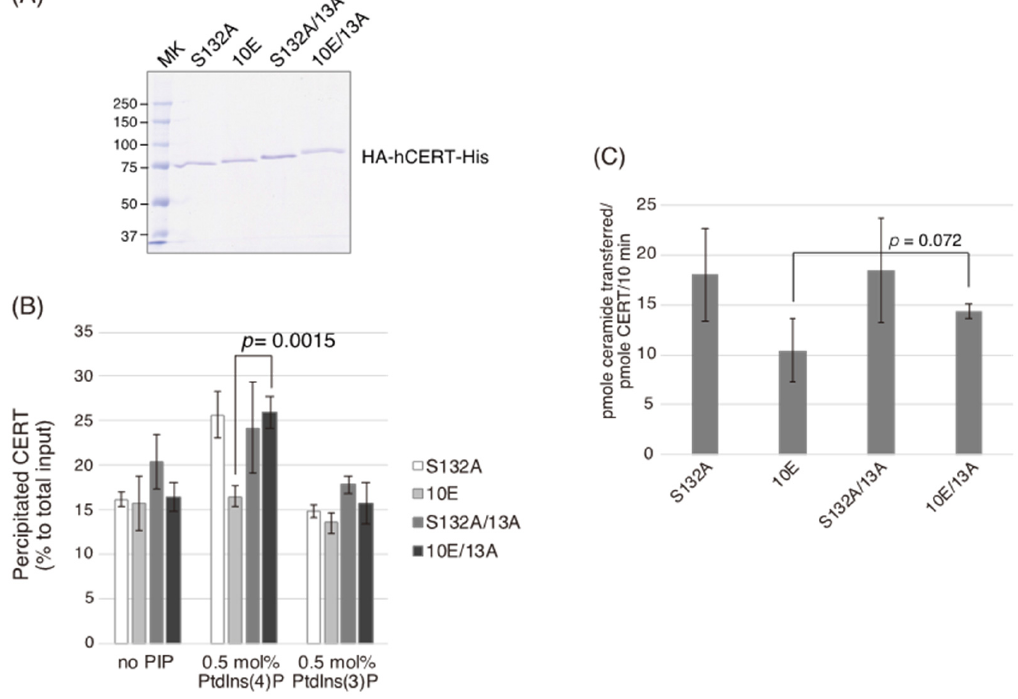
Figure 5. The 13A mutation restores the ceramide-transfer and PtdIns(4)P-binding activities of CERT 10E. ( A ) Quantities (0.5 µ g) of recombinant CERT S132A, 10E, S132A/13A, and 10E/13A proteins purified from Sf21 cells were resolved by SDS-PAGE and stained with Coomassie brilliant blue. ( B ) The binding of purified WT and CERT mutants to liposomes without or with 0.5 mol% PtdIns(3)P or PtdIns(4)P was determined by quantification of their distribution in the supernatant and pellet fractions, respectively. Results shown are the means and SEM of three experiments. Sig- nificance was determined using a two-tailed Student’s t -test; p -values < 0.05 were considered statis- tically significant. ( C ) The transfer of [ 14 C]ceramide from donor to acceptor liposomes by CERT was measured. Results shown are the means and SEM of four experiments. Significance was determined using a two-tailed Student’s t -test; p -values < 0.05 were considered statistically significant. 2.5. The 13A Mutation Partially Destabilizes the Trimeric State of CERT As the CCR is located in the vicinity of a region between amino acids 260 and 264, which was previously reported to be required for CERT trimerization (Figure 1A) [19], we assessed the oligomerization states of the four CERT constructs. To this end, the purified proteins were treated with a non-cleavable chemical cross-linker [ethylene glycol bis (suc- cinimidyl succinate); EGS] at various concentrations, separated using SDS-PAGE, and subjected to western blotting analysis. When treated with 0.1–0.8 mM EGS, trimer forms were predominant among cross-linked oligomers for both CERT S132A and CERT 10E (Figures 6A,B and S5), in line with a previous study [19]. Compared with CERT S132A and CERT 10E, their 13A variants (CERT 10E/13A and S132/13A) produced more dimer forms in addition to the non-linked monomer and cross-linked trimer forms (Figures 6B and S5), suggesting that the 13A mutation partially destabilized the CERT trimeric forms. We also employed blue native PAGE to examine the oligomerization states of the mutants and confirmed that CERT S132A and 10E showed mobilities corresponding mainly to the molecular weights of the homo-trimers, while CERT S132A/13A and 10E/13A migrated like a nearly equivalent mixture of trimers and dimers (Figure 6C). This is consistent with the above results of the cross-linking experiments (Figure 6A,B). Thus, although CERT S132A/13A and 10E/13A retain the ability to homo-trimerize, the 13A mu- tation might partially destabilize the trimeric state of CERT.